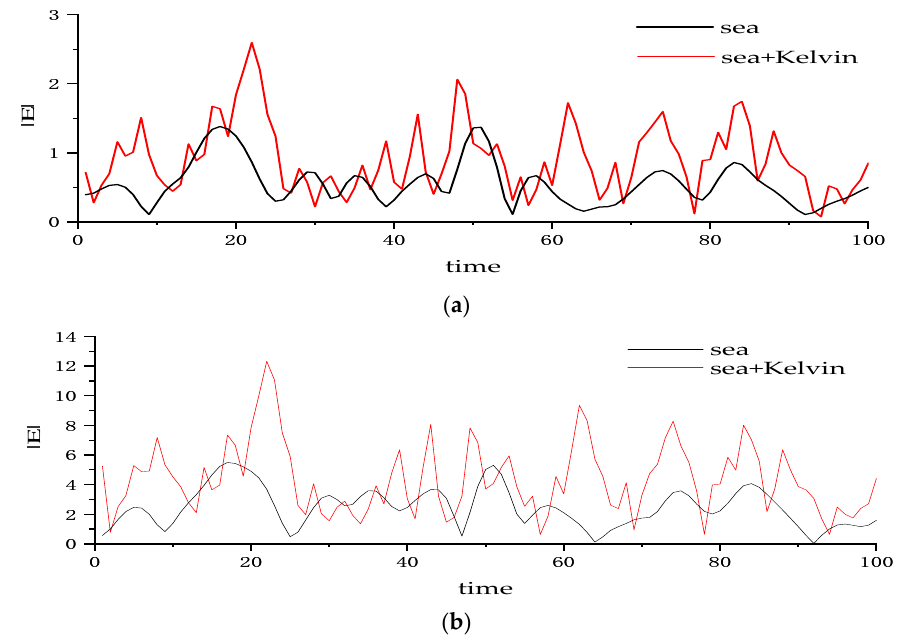
Figure 11. Change of modulus of radar scattering echo with time. The simulation of the backscattering Doppler spectrum when the incident electromagnetic wave frequency is 5 GHz will be analyzed below. In the resulting Doppler spectrum, the location of the Bragg frequency is marked by a green vertical line. Figure 12 shows the Doppler spectra of different ship speeds at wind speed u = 5 m/s; wind direction φ w = 0°; incident angle θ i = 30°, 60°, and 80°; ship speed Us = 5 m/s, 8 m/s, and 10 m/s; HH polarization; and VV polarization: (a), (c), and (e) for the Doppler spec- trum at HH polarization; (b), (d), and (f) for the Doppler spectrum at VV polarization.